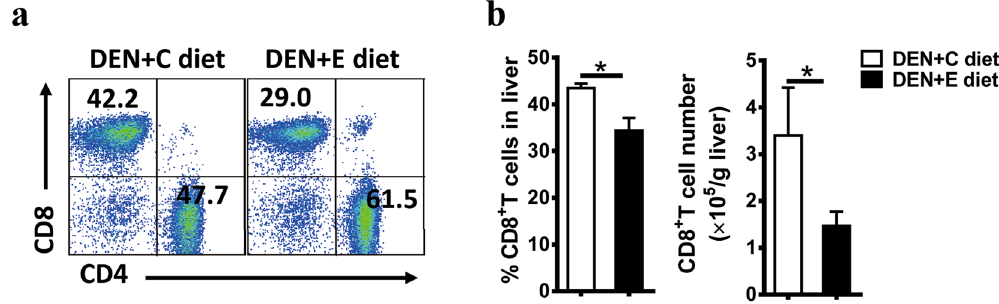
Figure 3. Alcohol consumption reduces CD8 + T cells in the liver in DEN-initiated tumorigenesis. ( a ) CD3 + CD4 + or CD3 + CD8 + T cell frequency in livers were evaluated by using FACS. ( b ) Statistical analysis of the percentage and absolute number of CD3 + CD8 + T cells in livers were performed in DEN + C diet and DEN + E diet mice. Data are shown as the means ± SEM (n = 4 for DEN + C diet, n = 6 for DEN + E diet). * P <